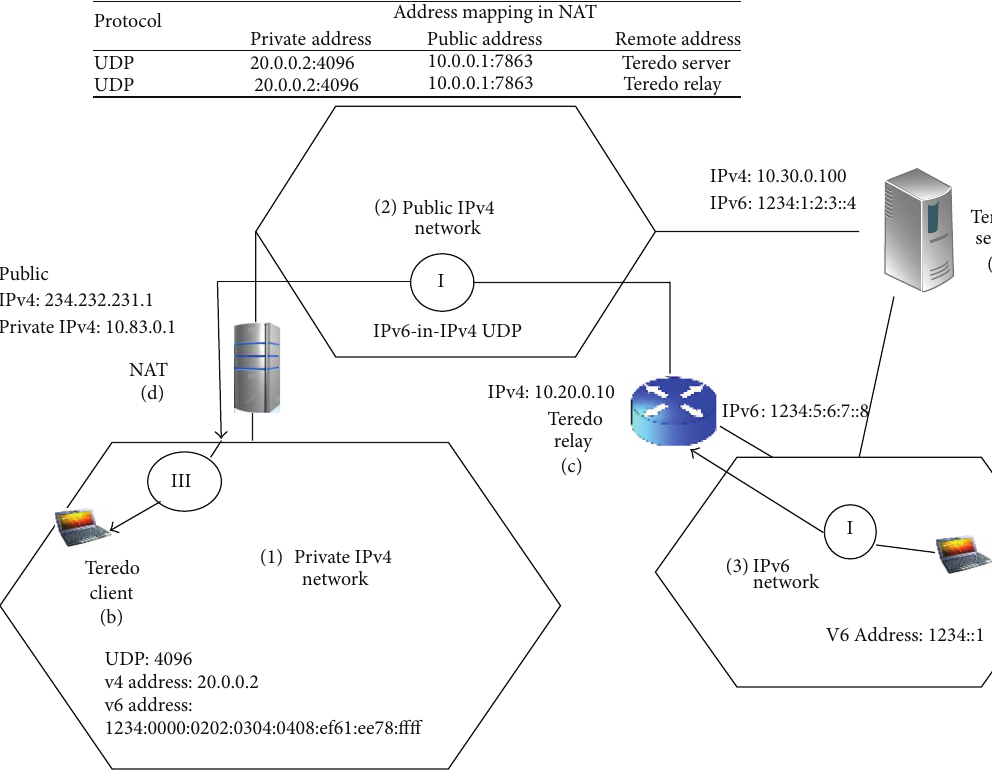
Figure 1: Teredo